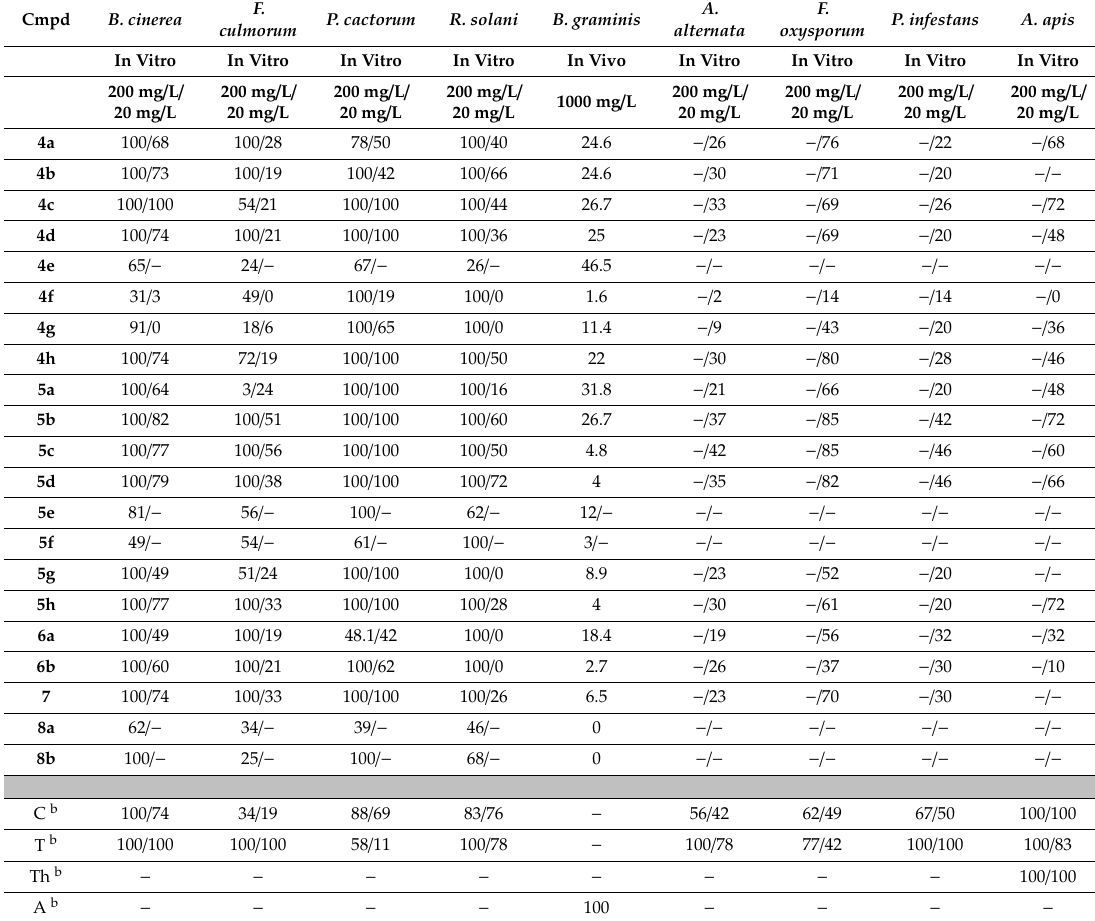
Table 1. Fungistatic activities a of selenoureas 4 – 8 at 200 mg / L and 20 mg /